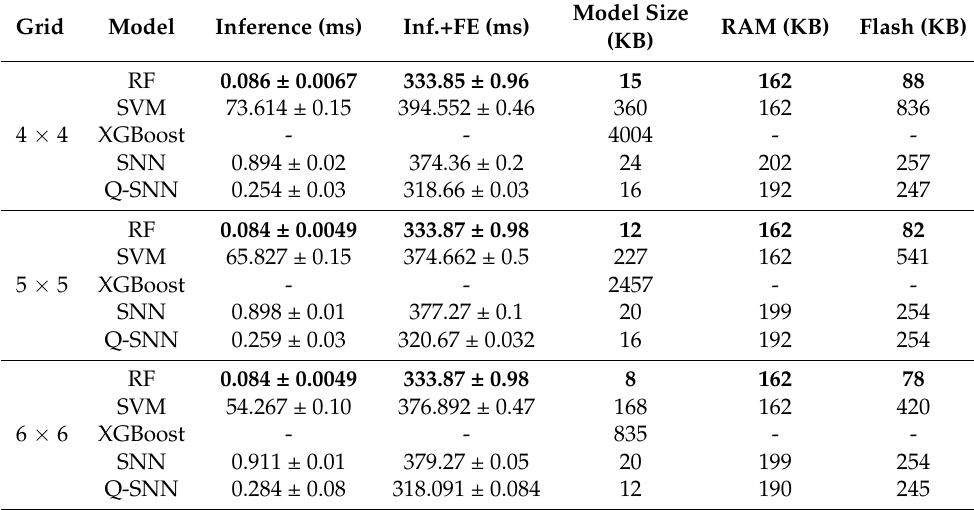
Table 7. On-device footprint evaluation metrics. The results from the best model per grid case are highlighted in